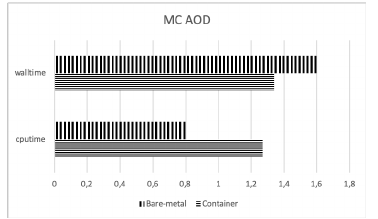
Figure 7. Timing comparison for reconstruc- tion test.